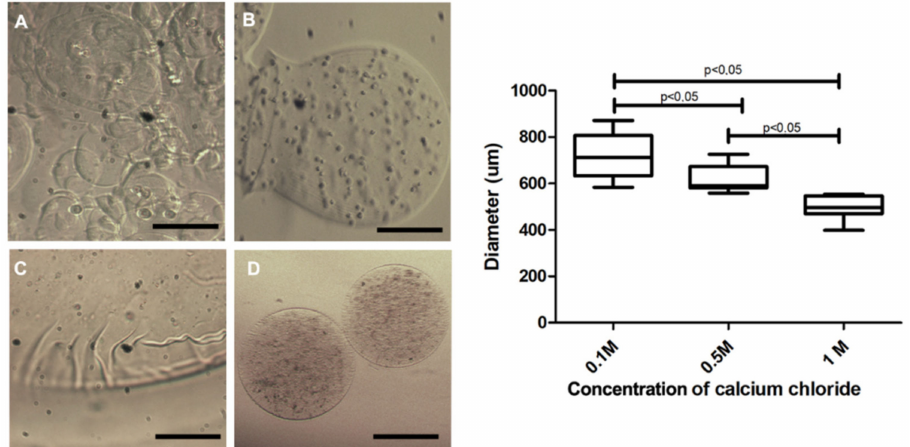
Figure 4. Capsule morphology produced with 3% sodium alginate and di ff erent calcium